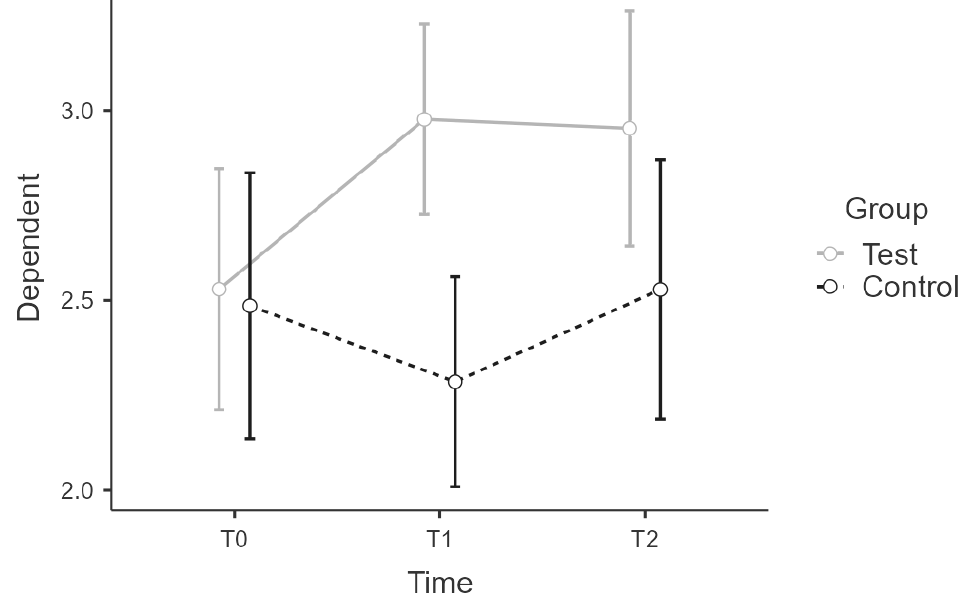
Figure 7. Estimated marginal means for CH complete score.